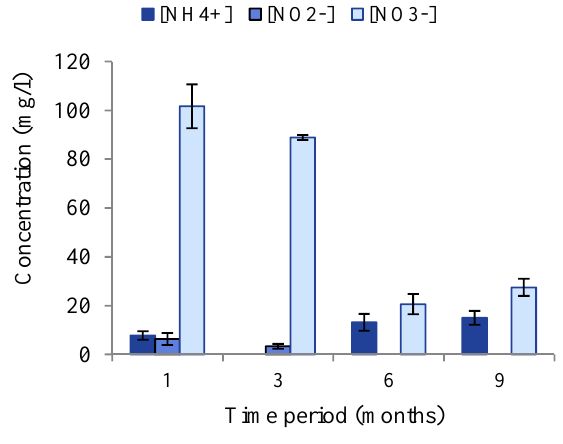
Figure 2. Nitrogen species composition dynamics in